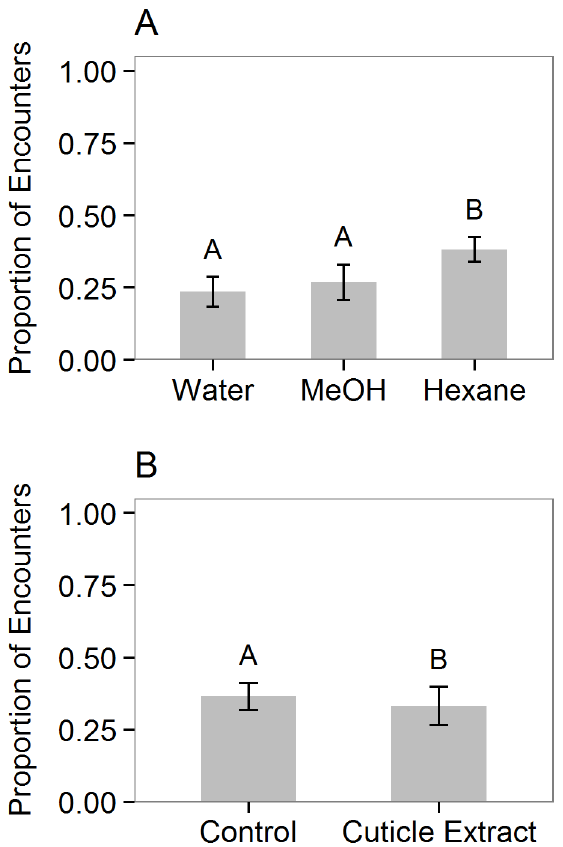
Figure 3. Response of Pseudomyrmex spinicola ants to Piezo- gaster reclusus and other herbivores. Bars show the mean proportion ( 6 SE) of encounters in which Pseudomyrmex spinicola ants attacked: (A) dead individuals of Piezogaster reclusus that were washed in water, methanol, or hexane to remove cuticular compounds, or (B) individuals of Dysdercus sp. that were treated with lanolin-extracted Piezogaster reclusus cuticular compounds or lanolin only as a control. Letters indicate significant differences from binomial GLMMs that included ant colony as a random effect.